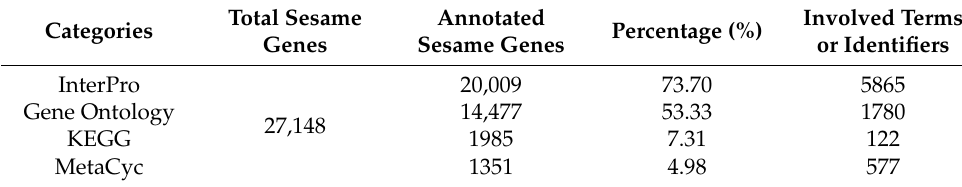
Table 2. Statistics of functional annotation of protein-coding genes in Sesamum indicum genome